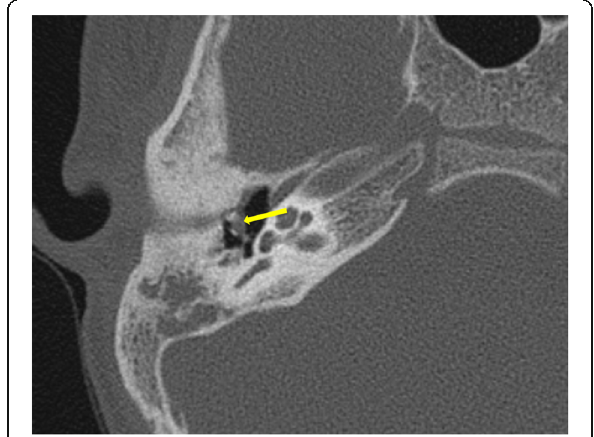
Fig. 4 Axial CT image showing non-dependent soft tissue medial to ossicles in a patient with pars tensa cholesteatoma (arrow)